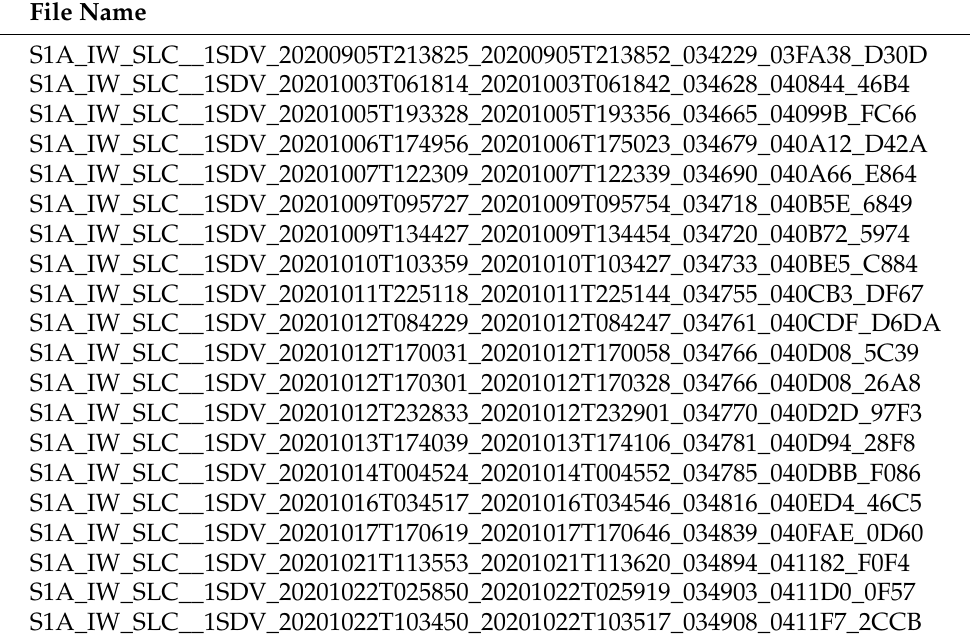
Table A1. File name list of the downloaded Sentinel-1